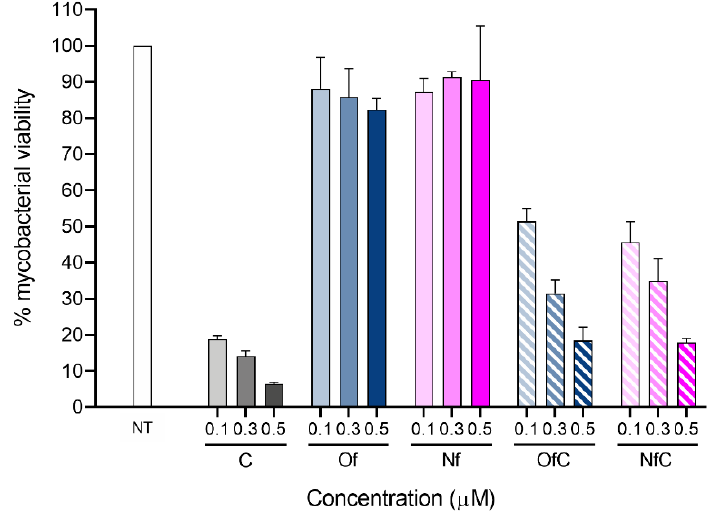
Figure 5. Activity of the API-OSs and respective parent drugs against intracellular mycobacteria. The graph shows the averages + standard deviations of one representative experiment, presented as the percentage of bacterial load to nontreated macrophages on day 5 of incubation.